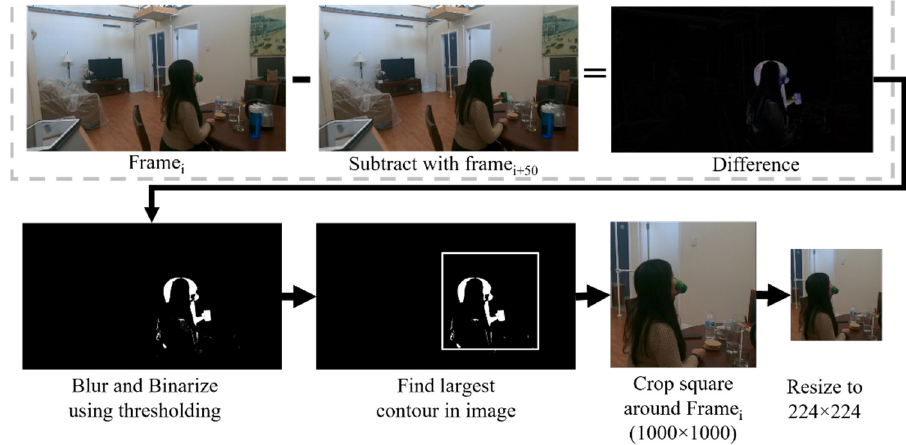
Figure 2. Description of the data processing method used in this paper.